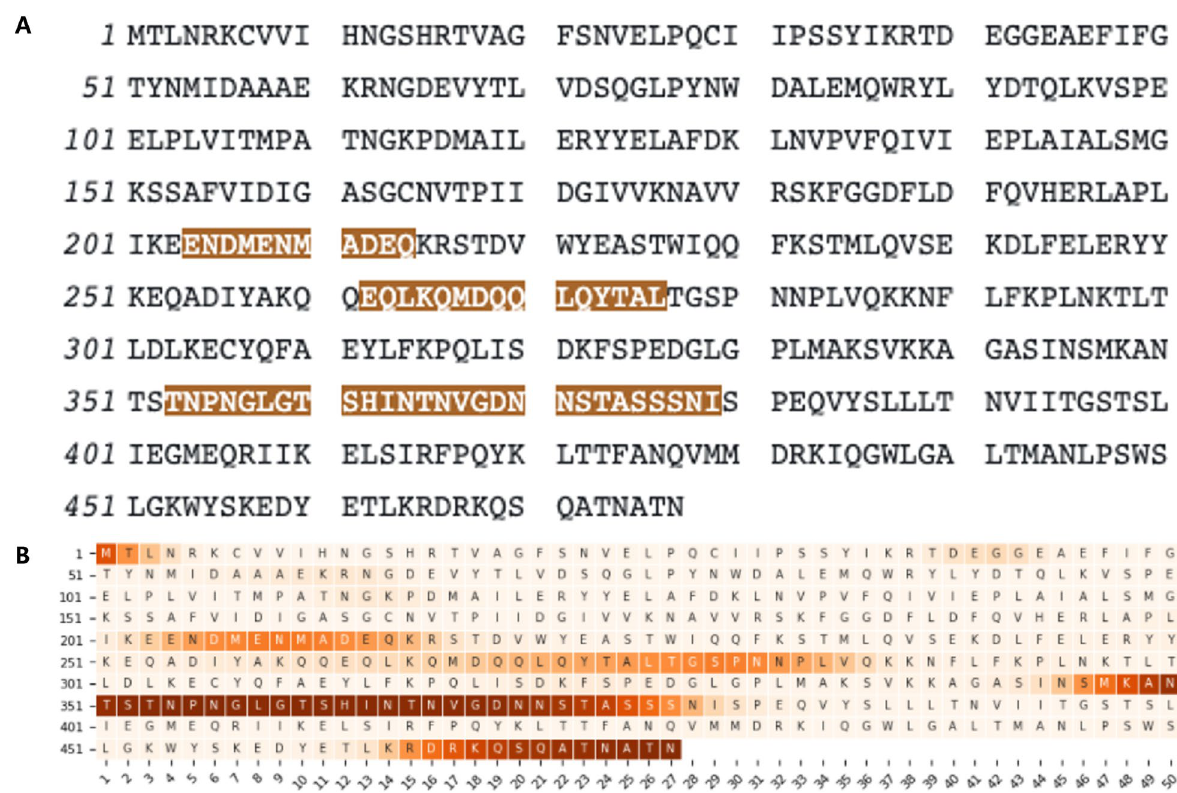
Figure 4. S-Pred IDR prediction for the DisProt ID DP00874 protein. ( A ) DisProt annotations. Disordered annotated residues are highlighted in brown. ( B ) S-Pred prediction. The probability of disorder is